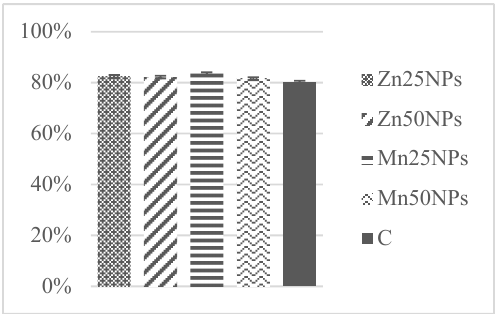
nificant differences at p ≤ 0.05. The bars with various letters are significantly different from one